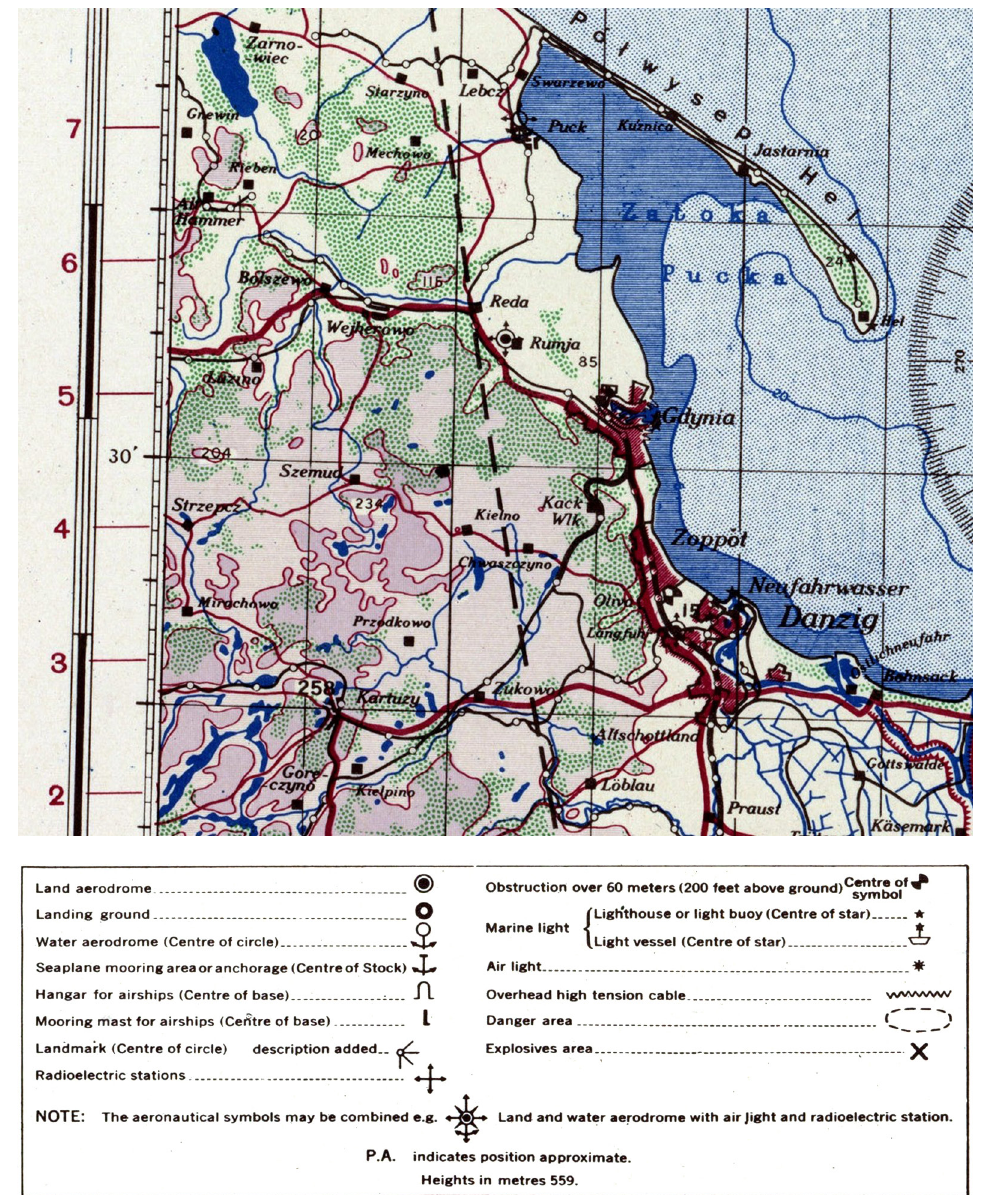
Fig. 6. Part of an aeronautical chart at the scale of 1:500,000, sheet Danzig N.E. 54/18,